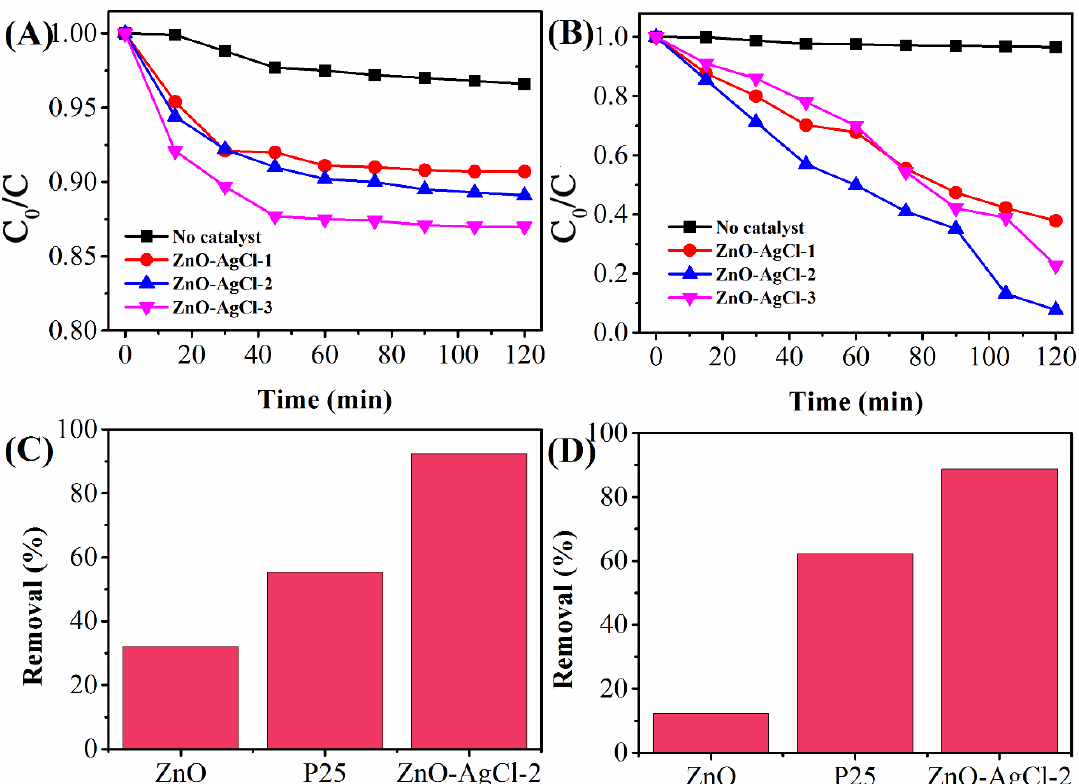
Fig. 3. (A) Degradation of MTBE over ZnO-AgCl-1, ZnO-AgCl-2 and ZnO-AgCl-3 without light irradiation. (B) Photodegradation of MTBE over ZnO-AgCl-1, ZnO-AgCl-2 and ZnO-AgCl-3. (C) MTBE removal rate using ZnO-AgCl-2, P25 and nano-ZnO under visible light irradiation. (D) MTBE removal rate using ZnO-AgCl-2, P25 and nano-ZnO under UV light